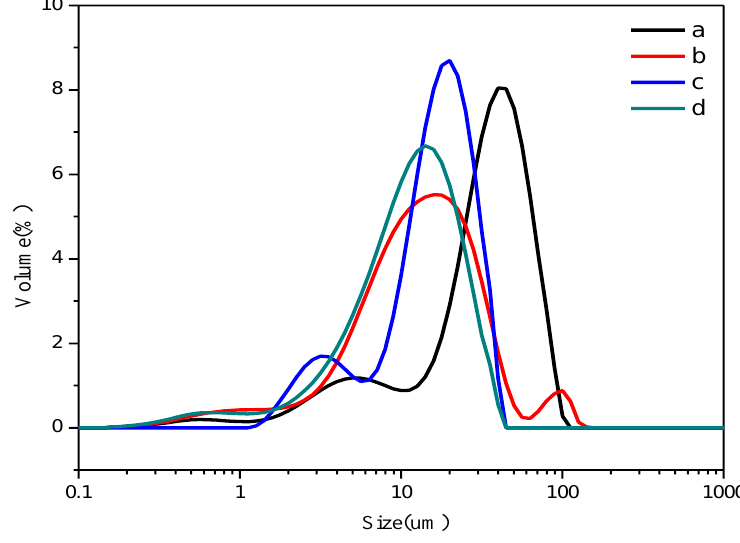
Figure 3. The particle size distribution of the support (a) and catalysts (Cat-1 b, Cat-2 c, Cat-3 d).